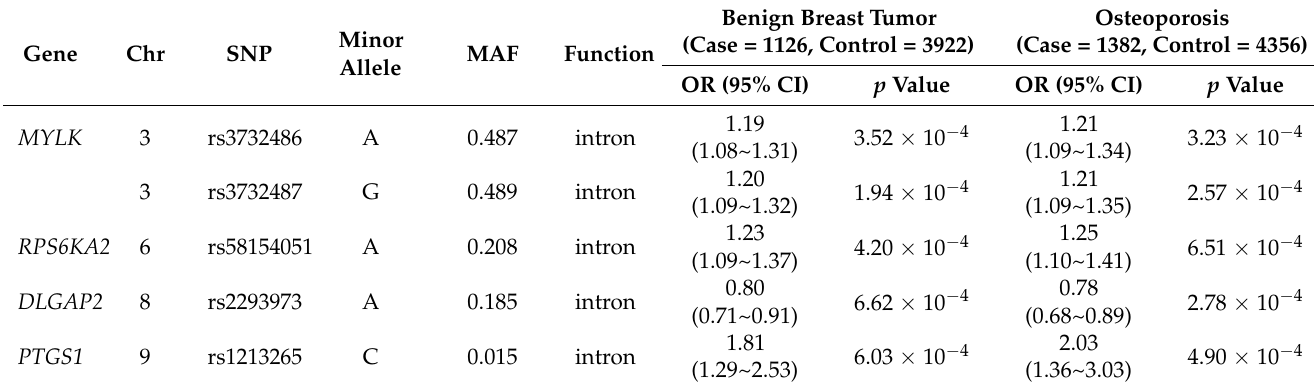
Table 2. Significant association of SNPs in both benign breast tumors and osteoporosis in the HEXA women cohort.